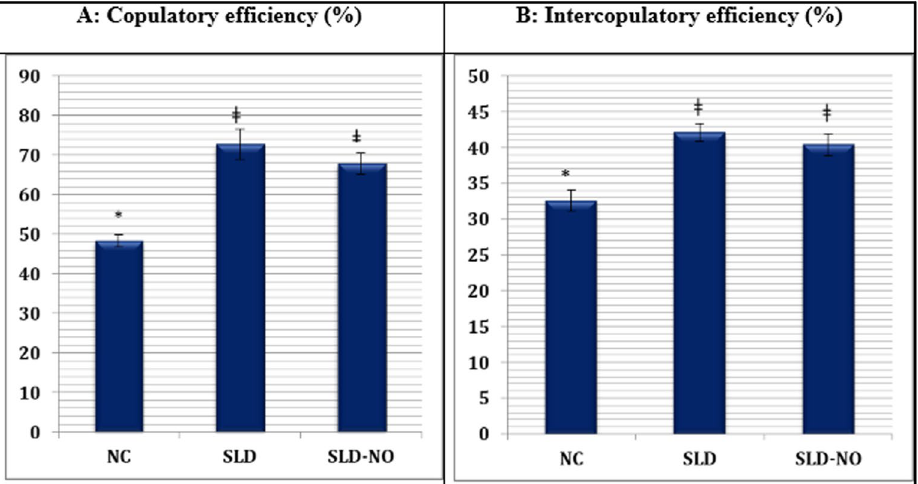
Figure 9. Effect of SLD and SLD N-oxide on the copulatory ( A ) and intercopulatory ( B ) efficiencies of male rats.